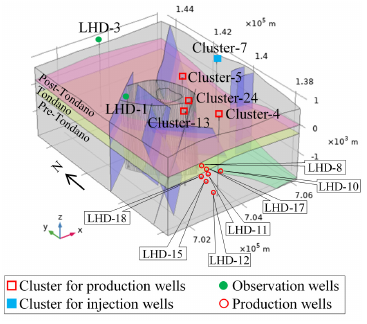
Figure 12. 3D model geometry.